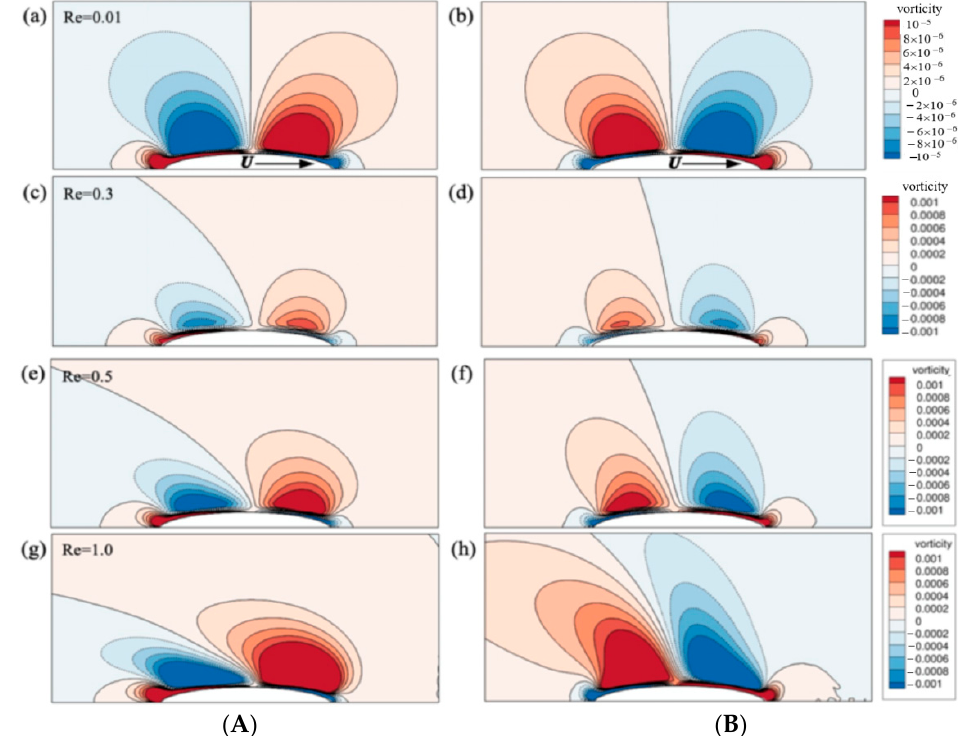
Figure 7. Vortical contours induced by elliptical squirmer with different Re for AR = 0.2. ( a , b ) Re = 0.01, ( c , d ) Re = 0.3, ( e , f ) Re = 0.5, ( g , h ) Re = 1.0. ( A ) pusher ( β = − 5) for different Re. ( B ) puller ( β = 5) for different For the pusher as shown in (a), the positive and negative vorticity appear ahead and behind the pusher, and the opposite is true for the puller as shown in (b). There are small tip vortexes at two poles of the squirmer with their direction being opposite to the adja- cent main vorticity at Re = 0.01. For the pusher as shown in (a), the symmetry of the main vortex and tip vortex are broken more quickly with increasing Re. When upstream fluid